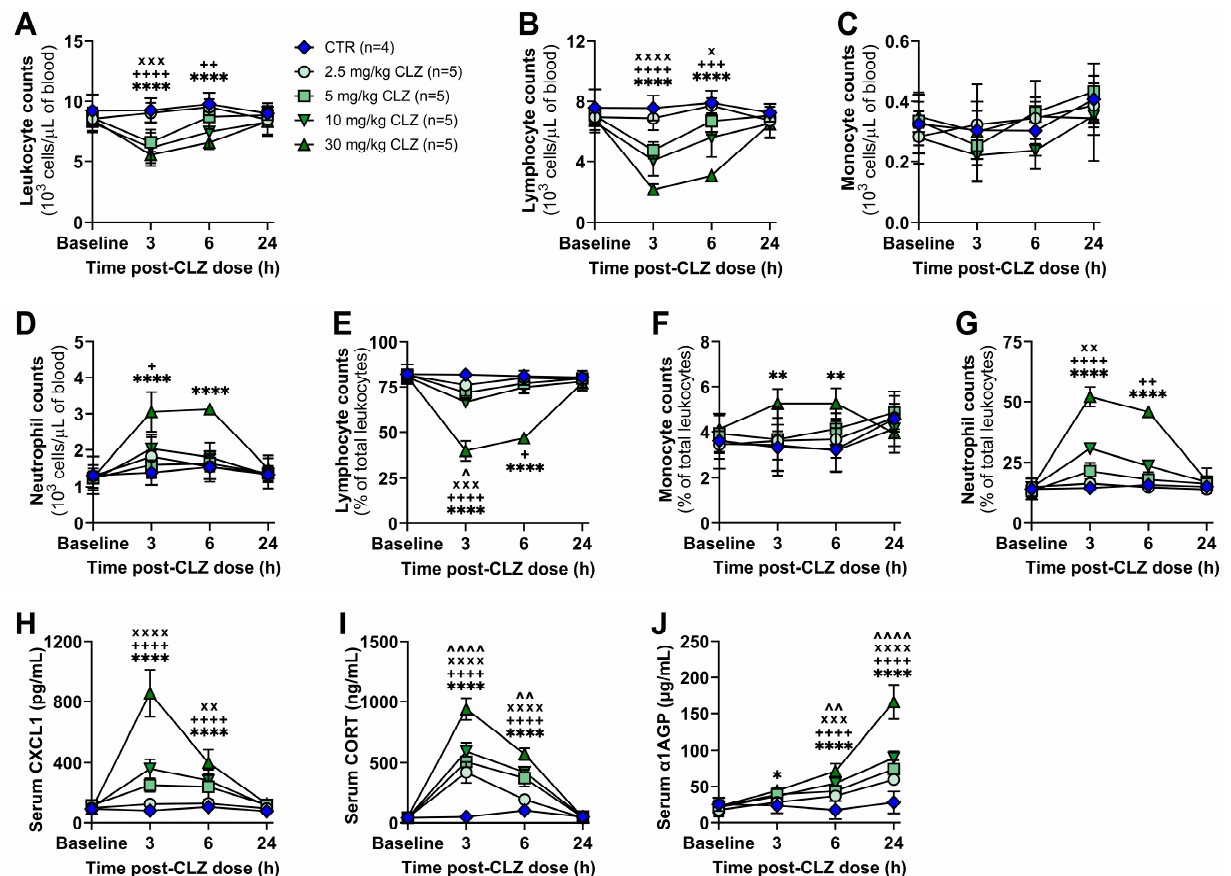
Figure 2. Clozapine triggers dose-related changes in circulating leukocytes and inflammatory media- tors in rats. ( A – D ) Absolute leukocyte ( A ), lymphocyte ( B ), monocyte ( C ), and neutrophil ( D ) counts, presented as 10 3 cells/ µ L of blood, in female Sprague Dawley rats over 24 h following treatment with saline (vehicle control, IP), or clozapine (2.5, 5, 10, or 30 mg/kg, IP). ( E – G ) Corresponding lymphocyte ( E ), monocyte ( F ), and neutrophil ( G ) counts, presented as a percentage of total leukocytes. Differential blood counts were determined using a VetScan HM5. ( H – J ) Serum concentrations of CXCL1 ( H ), corticosterone ( I ), and α 1AGP ( J ) over 24 h post-clozapine administration. Inflammatory mediators were quantified using commercially available ELISA kits. Results are presented as the mean ± SD, and the statistical difference between groups was determined by a repeat-measure two-way ANOVA with the Holm-Sidak’s test for multiple comparisons. CTR, control; CLZ, clozapine; CORT, corticosterone; α 1AGP, alpha-1 acid glycoprotein; ^ , p < 0.05; ^^ , p < 0.01; ^^^^ , p < 0.0001 (2.5 mg/kg